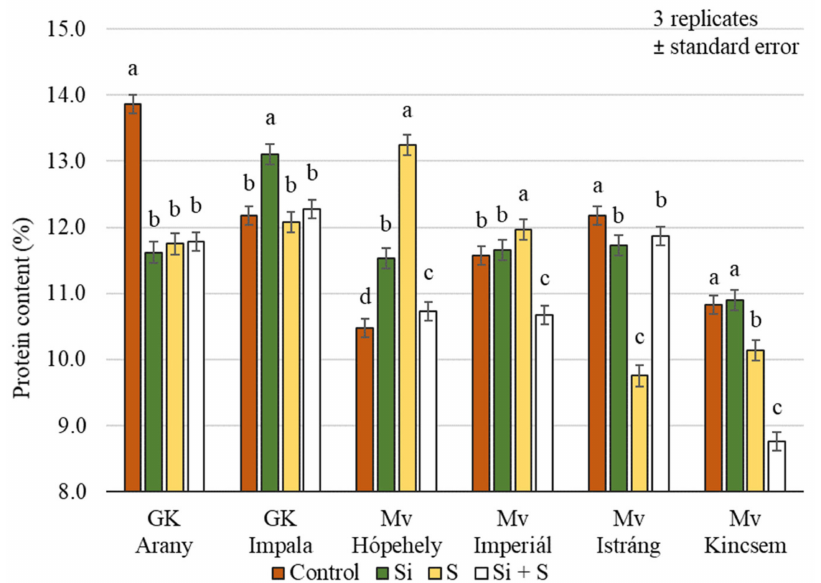
Figure 8. Whole grains protein content of the winter oat varieties as a function of foliar fertilisation treatments; ± standard error of means. 3 replicates. The different letters show significantly differing values among the treatments in the varieties, at p = 0.05 level.